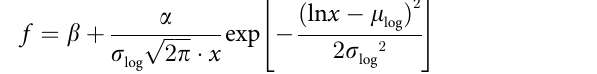
Fig 10. Statistical distributions of formaldehyde emission values (40 L desiccator value, derived from multiple tests) of various materials characterized by the 40 L desiccator method of the Chinese national standard GB 18580. (a) MDF, medium density fiberboard. (b) PB, particleboard. (c) BB, blockboard. (d) LF, laminate flooring. (e) PQ, parquet. The frequency denoted the number of data occurred at corresponding formaldehyde emission levels. These data were fitted by the probability density function of a Gaussian